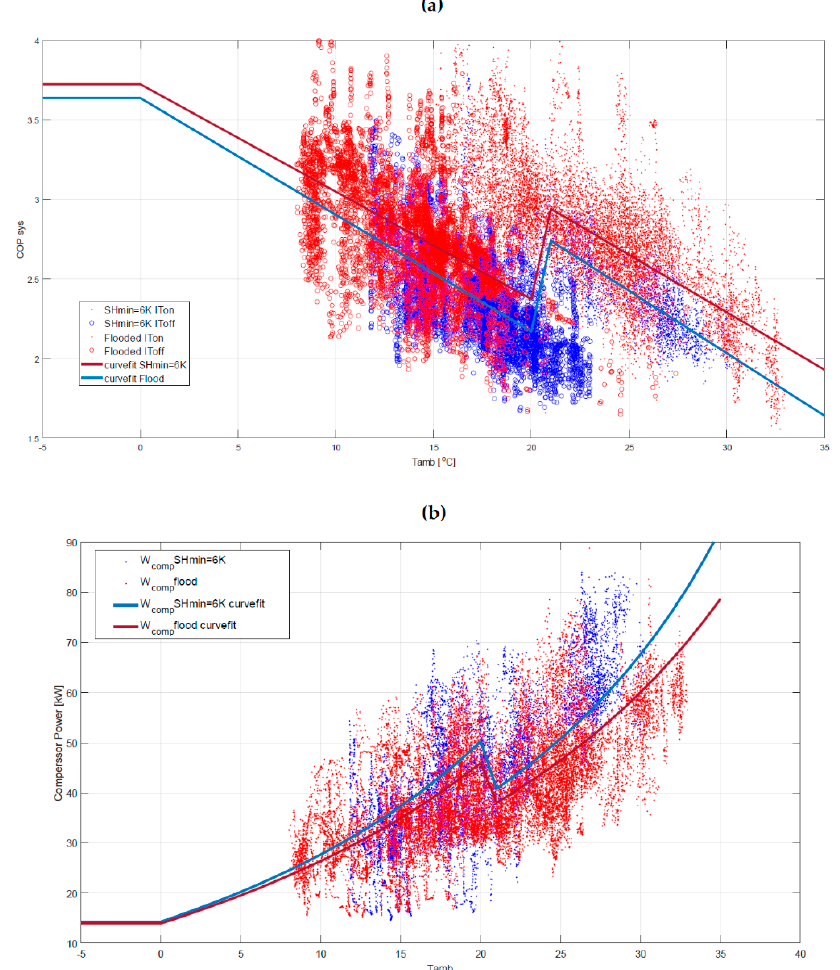
Figure 19. Comparison of total COP values ( a ) and total compressor power input (kW) ( b ) between the investigated system using MT dry-expansion evaporators with a minimum degree of superheating of 6 K (blue line) and the same system relying on MT flooded evaporators with a 6 K (blue line) and the same system relying on MT flooded evaporators with a minimum degree of minimum degree of superheating set to 1 K (red line) [60]. superheating set to 1 K (red line)